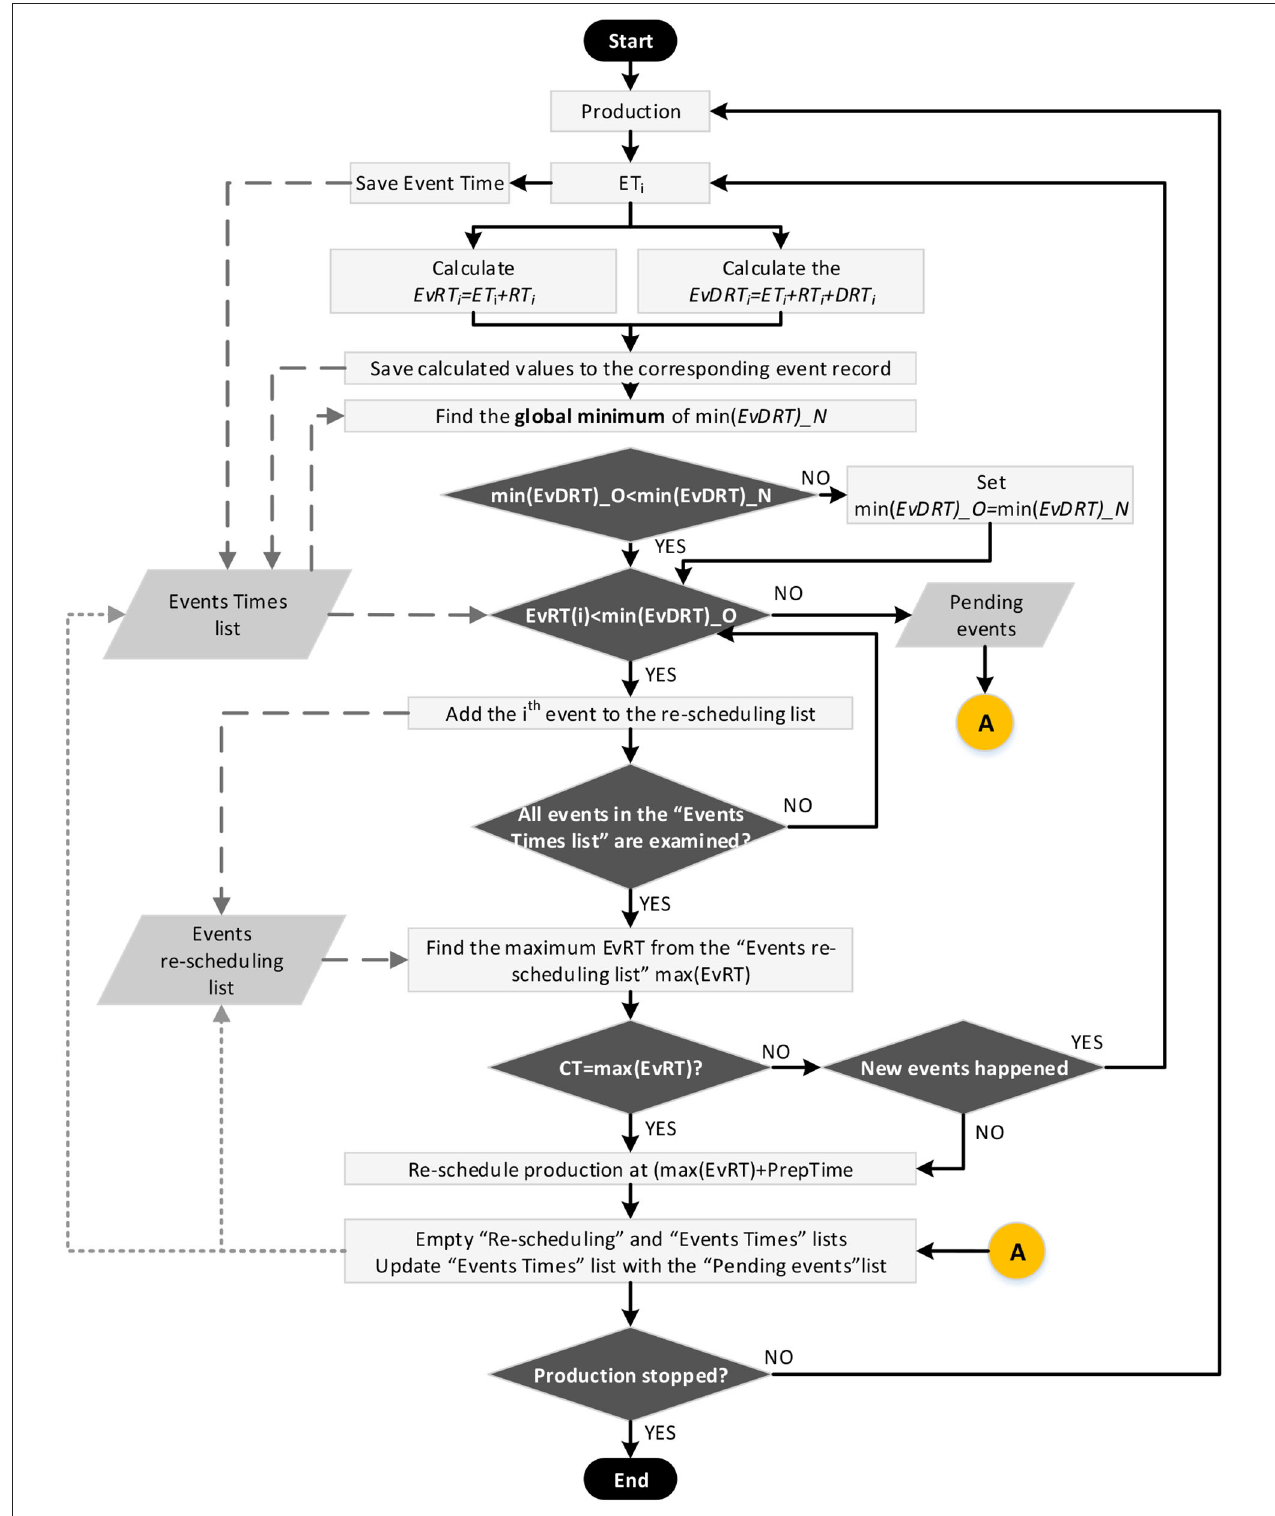
FIGURE 1 | Events management